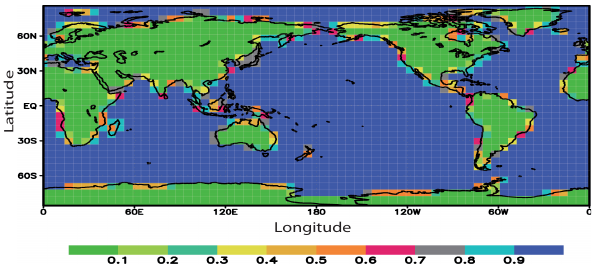
Fig. 8. Fraction of ocean surface in each of the grid cell of ECBilt.